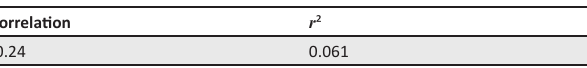
TABLE 10: Correlation and r 2 between the consumer price index and the cost to